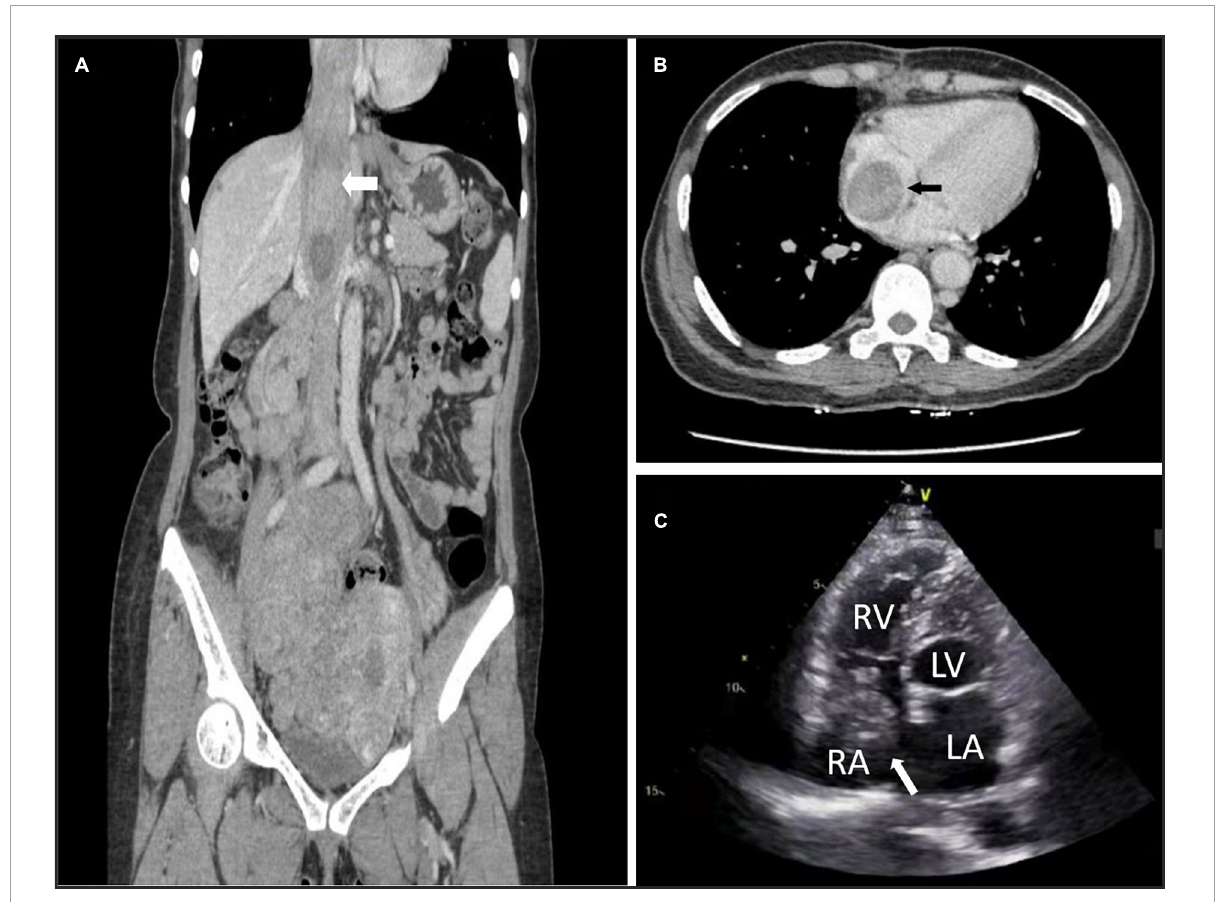
FIGURE1 Preoperative computed tomography venography (CTV) and echocardiography can detect tumors. (A) Image of patient 5 showing intracardiac leiomyomatosis (ICL) extending through the inferior vena cava (IVC) to the right atrium (RA) (white arrow). (B) Image of patient 3 showing a tumor within the RA (black arrow). (C) Echocardiogram of patient 10 shows a solid intracardiac head. LA, left atrium (white arrow); LV, left ventricle; RV, right